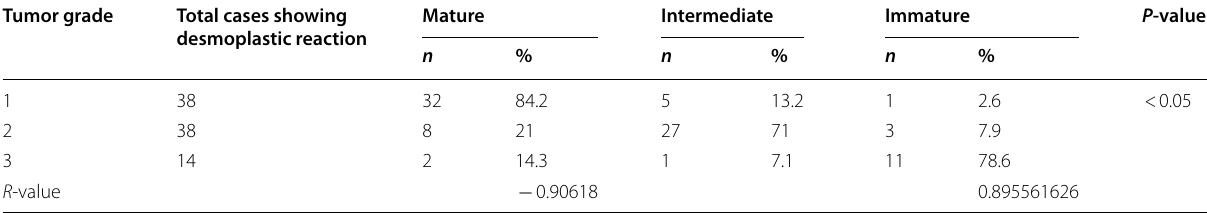
Table 3 Association between tumor grade and type of stromal desmoplastic reaction Tumor grade